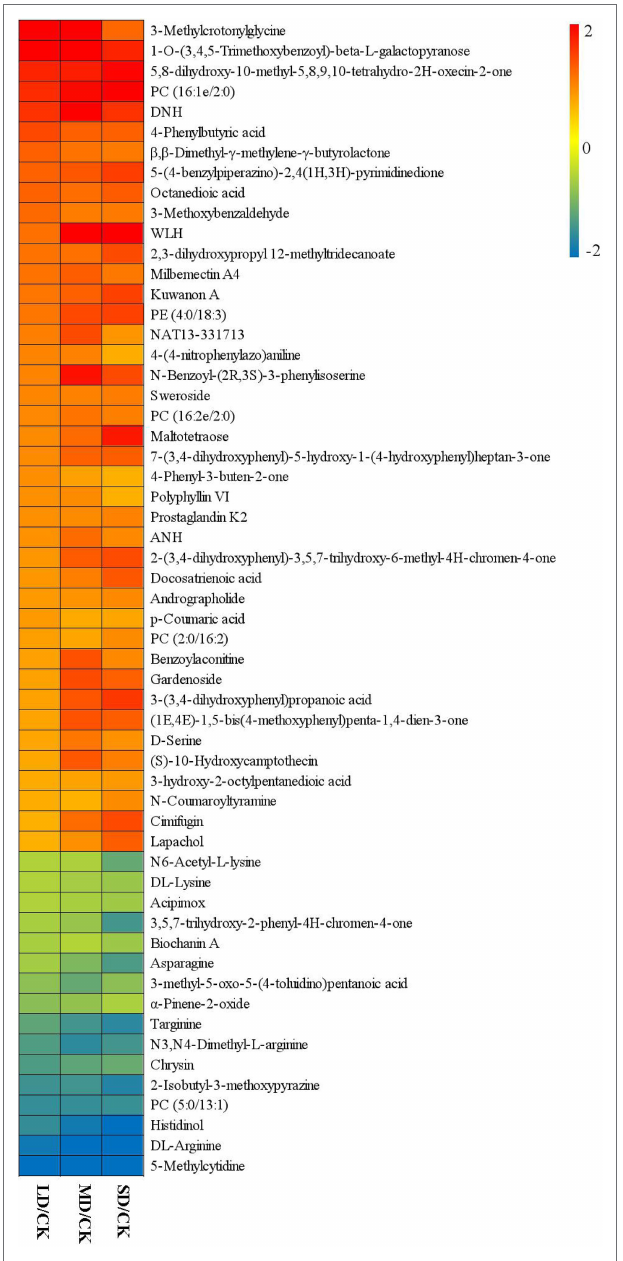
FIGURE 4 | Fold-changes (FCs) of 57 common differentially accumulated metabolites in the four treatment groups. Green indicates downregulated expression, and red indicates upregulated